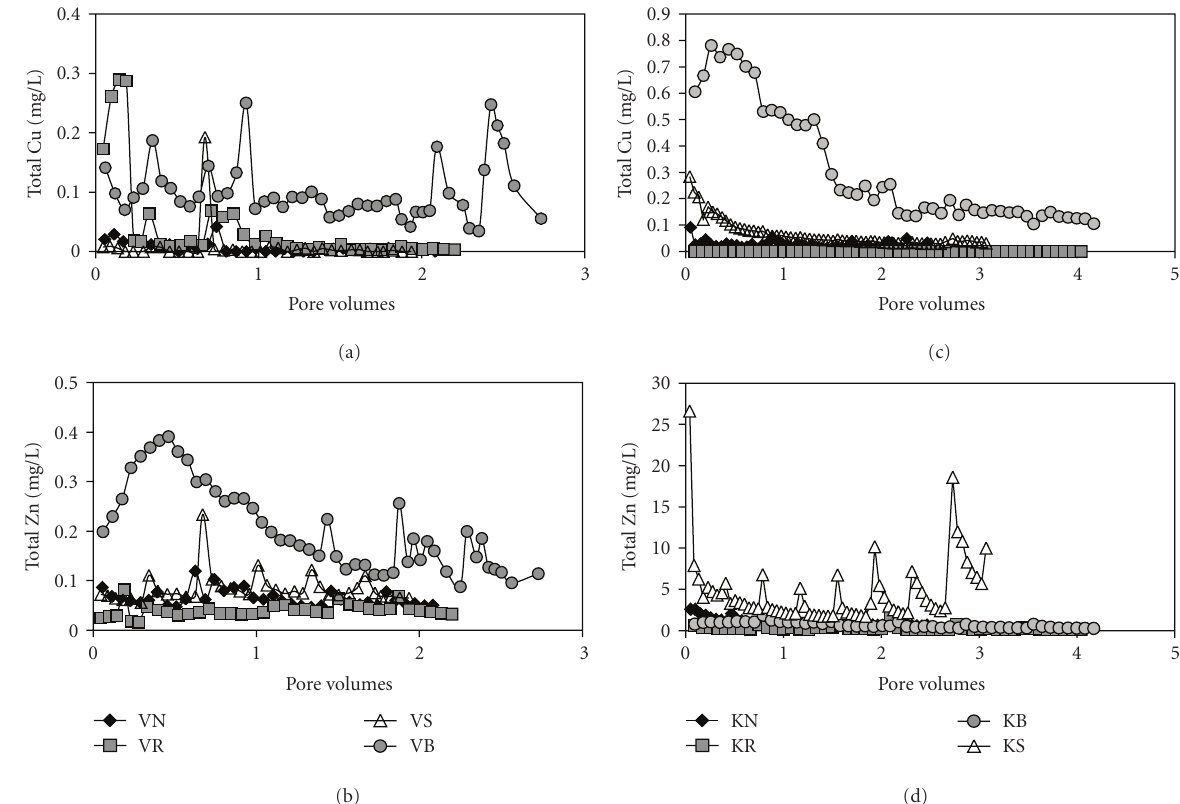
Figure 3: Total (colloid and solution) concentrations (mg L − 1 ) of Cu and Zn in Virginia (a, b) and Kentucky (c, d) monoliths over the entire leaching. VN: Virginia Natural, VR: Virginia Reclaimed, VS: Virginia Spoil, VB: Virginia Biosolids, KN: Kentucky Natural, KR: Kentucky Reclaimed, KS: Kentucky Spoil, KB: Kentucky